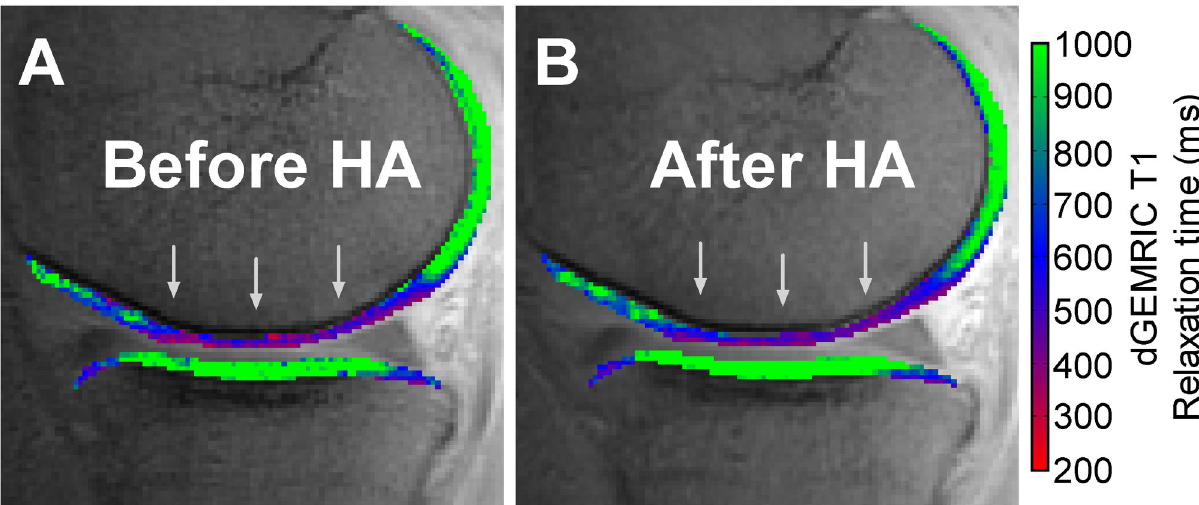
Figure 2. dGEMRIC color overlay representing cartilage sGAG content at baseline and follow-up. Representative sagittal central MR image through the medial tibiofemoral compartment of an early-stage OA knee before (A) and after (B) viscosupplementation with HA. The T1 color map of the cartilage clearly shows a region with relatively lower T1 relaxation times (grey arrows in A), indicating relatively lower sGAG content in the weight-bearing femoral cartilage before viscosupplementation (A). After HA injections (B), however, the region with relatively low T1 relaxation times is still present (grey arrows in B).